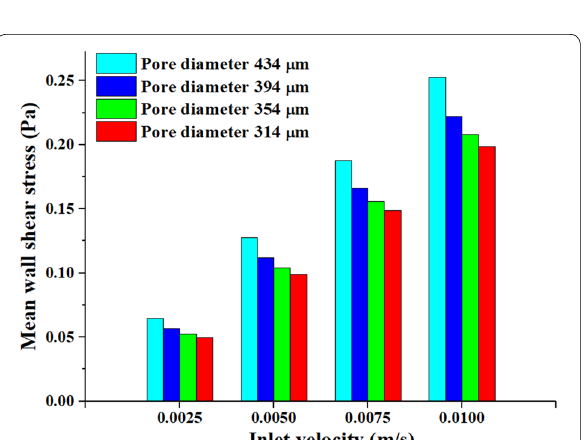
Figure 19 Mean wall shear stress with different pore diameters and inlet velocities